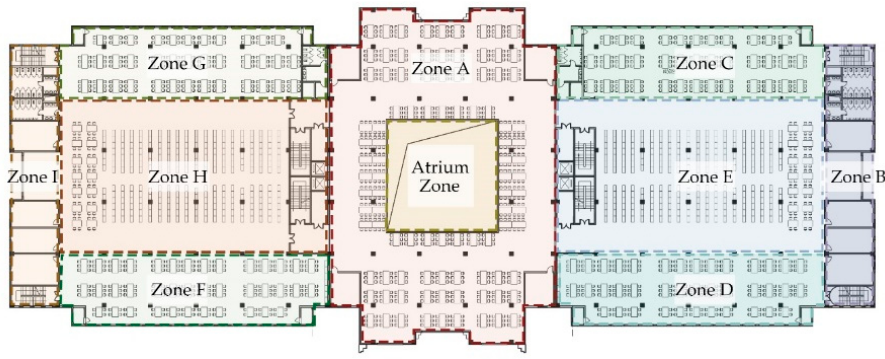
Figure 6. Thermal zones in the reference building.